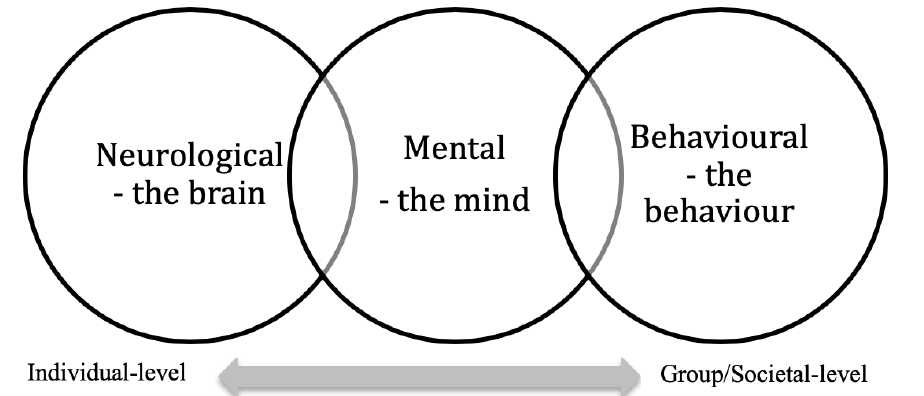
Fig. 1. Levels of analysis for science of managing for innovation (Source: Adapted from Lilienfeld et al.,